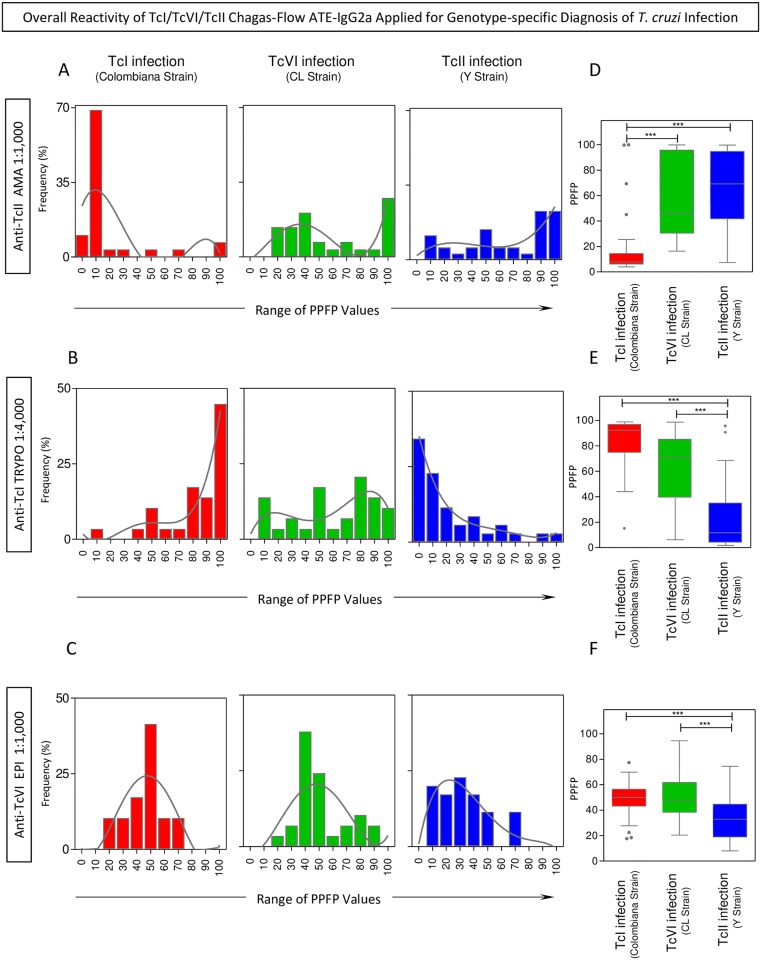
Overall reactivity of TcI/TcVI/TcII Chagas-Flow ATE-IgG2a applied for genotype-specific diagnosis of T. cruzi-infection.(A) The anti-TcII AMA reactivity at 1:1,000, (B) the anti-TcI TRYPO reactivity at 1:4,000 and (C) the anti-TcVI EPI reactivity at 1:1,000, pre-selected as attributes for genotypic-specific diagnosis of T. cruzi-infection, were further evaluated by histogram plot distributions and trendlines built by nonlinear regression. The results were expressed as the proportion of samples displaying a given PPFP values amongst T. cruzi-infected hosts, including: TcI/Colombiana strain (red bar, n = 29), TcVI/CL strain (green bar, n = 29) and TcII/Y strain (blue bar, n = 35). The reactivity amongst T. cruzi-infected groups was further compared for each pair of attributes, including: (D) anti-TcII AMA reactivity at 1:1,000, (E) the anti-TcI TRYPO reactivity at 1:4,000 and (F) the anti-TcVI EPI reactivity at 1:1,000. The results are expressed as median PPFP values in box plot format with the outliers underscored by gray-shaded dots. Data analyses were carried out by Kruskal-Wallis followed by Dunn’s post test for multi-group comparisons The significant differences were indicated by asterisk at *p <0.05, **p<0,001 and ***p<0,0001 and highlighted by connecting lines.